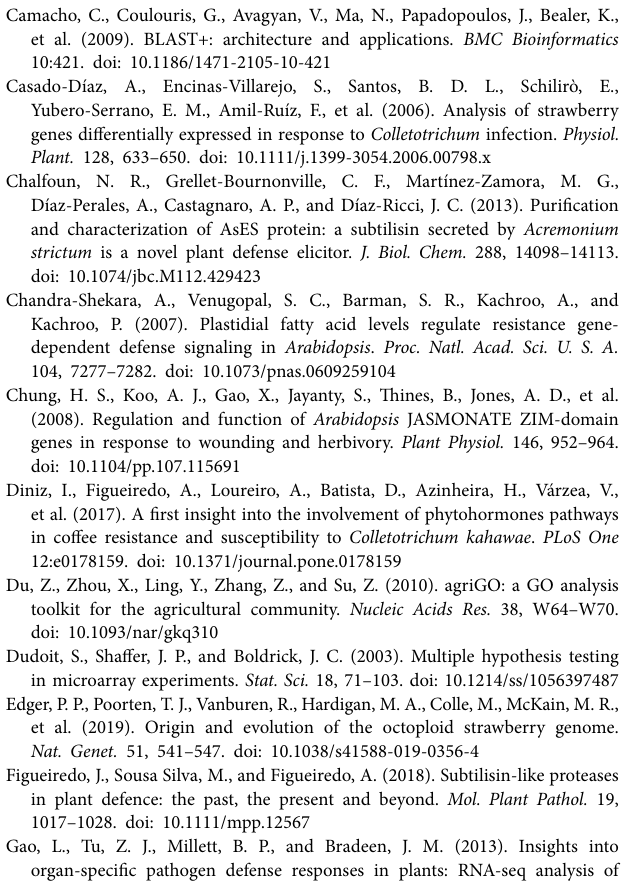
Supplementary Figure S1 | Heatmap representation of the differentially expressed genes enriched GO process under the category of molecular function. Supplementary Figure S2 | Heatmap representation of the differentially expressed genes enriched GO process under the category of cellular component. Supplementary Figure S3 | Resistance to C. gloeosporioides crown rot in NCH 11-309 (A,B) and early tolerance in NCK 12-199D (C,D) during late summer